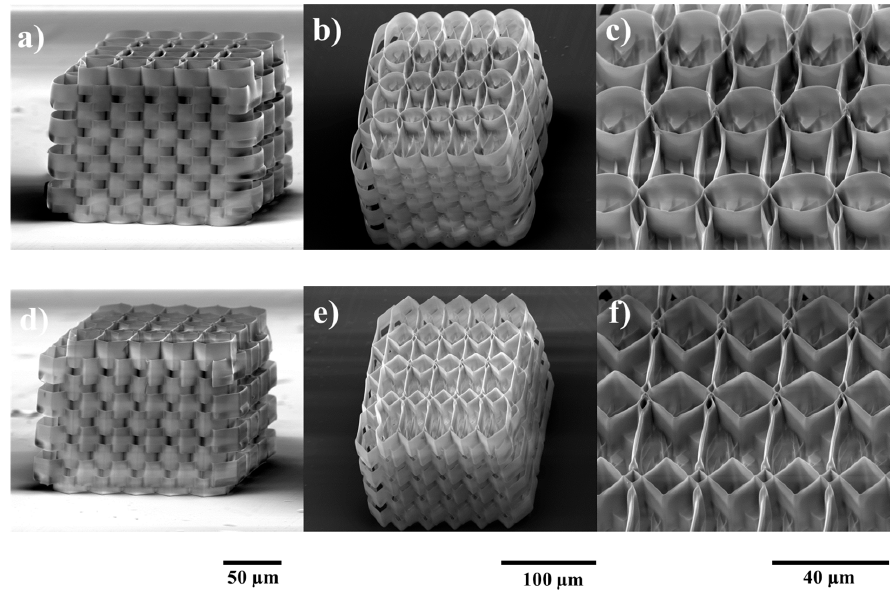
Figure 1. SEM micrographs of ellipsoidal (upper panel) and hexagonal (lower panel) multilayered 3D structures produced by LDW (laser direct writing) via TPP (two photon polymerization) of IP-L780 photopolymer. ( a,d ) Side overviews; ( b,e ) Tiled overviews; ( c,f ) Closer, tilted views of the structures.